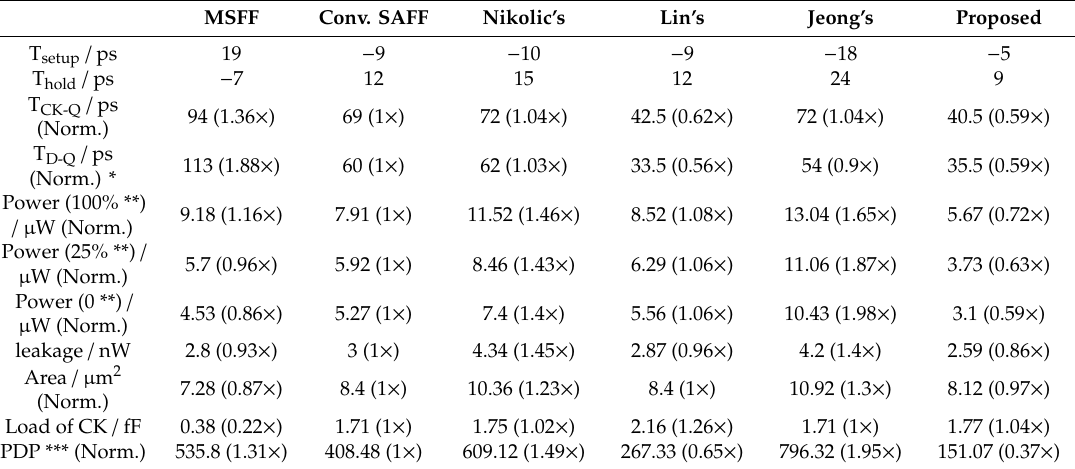
Table 6. Performance summary and comparison of various